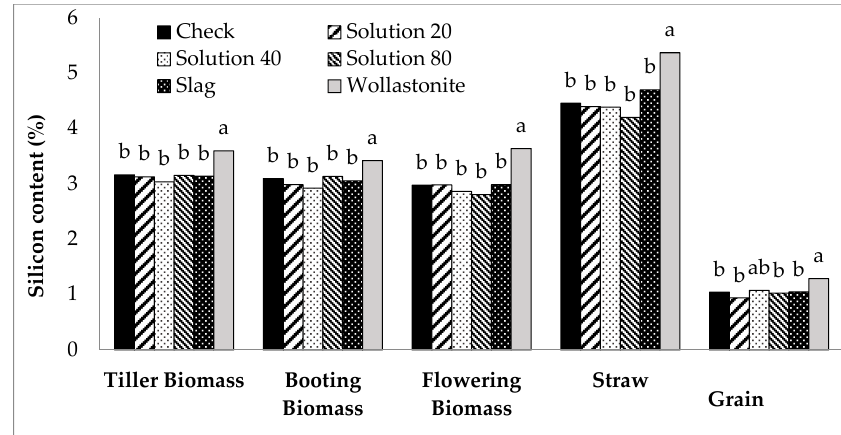
Figure 1. Effect of silicon treatments across phosphorus rates on silicon content of rice biomass at tiller, booting, and flowering, and of straw and grain at harvest. Bars labeled with the same letter within sampling time are not significantly different at P < 0.05 according to Tukey’s test. Slag and wollastonite rates: 690 and 1190 kg Si ha − 1 ,